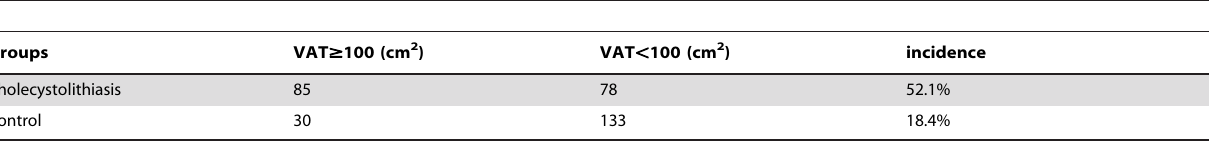
Table 2. The incidence of intra-abdominal fat increased accumulation on MRI between the cholecystolithiasis group and the control group.